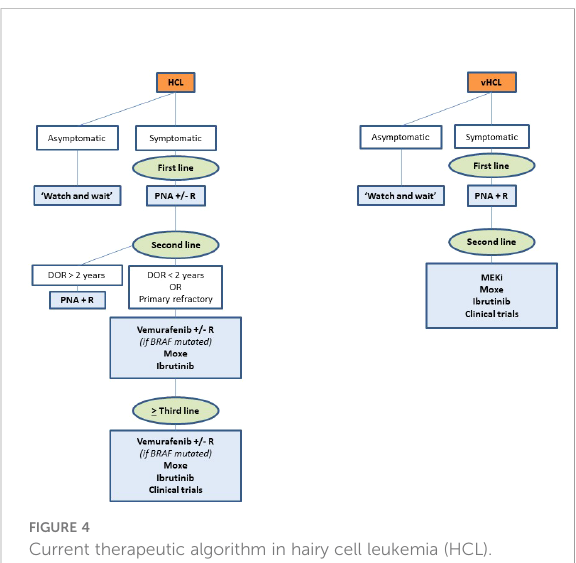
FIGURE 4 Current therapeutic algorithm in hairy cell leukemia